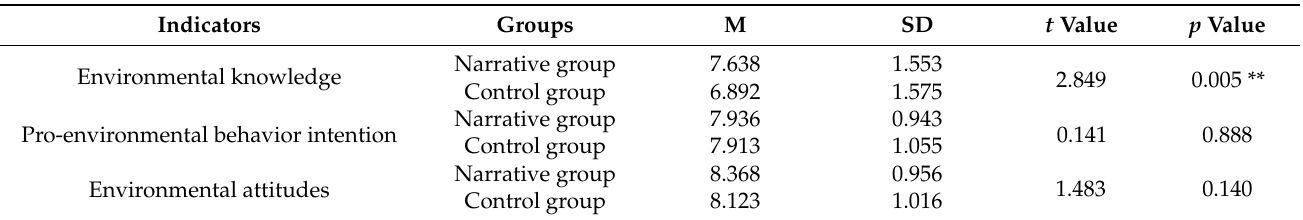
Table 2. The descriptive statistics of the indicators of children’s environmental awareness and the independent samples t -test